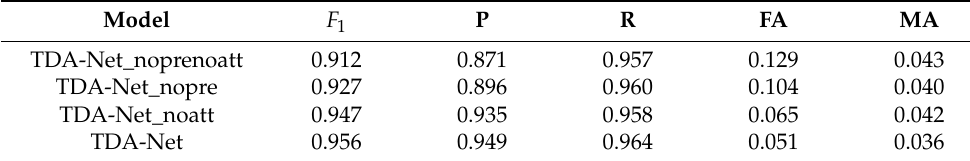
Table 4. Table of precision evaluation.